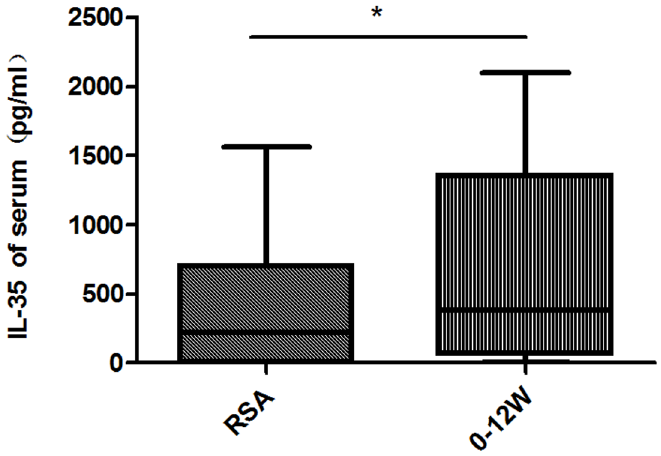
Fig 3. The serum levels of IL-35 in women suffering recurrent spontaneous abortion. 0 – 12 weeks: first trimester; RSA: recurrent spontaneous abortion; * P < 0.05; ns: not significant.